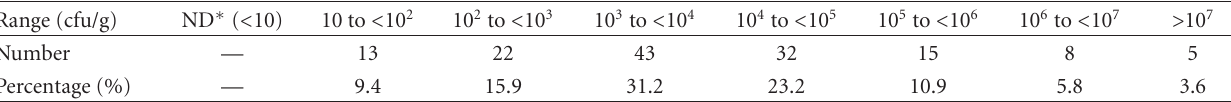
Table 2: Distribution and evaluation of mould contamination in Tarhana samples ( n = 138).